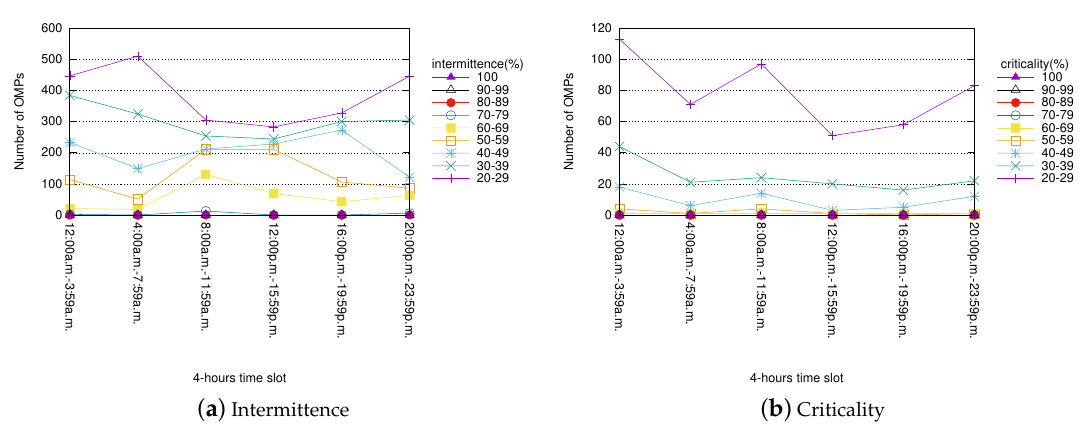
Figure 10. Bicing (Barcelona). Distribution of the number of OMPs and their corresponding levels of intermittence/criticality with a time slot granularity of 4 h. maxdist = 0.5 km. full-th = 3. time slot size = 4 h.